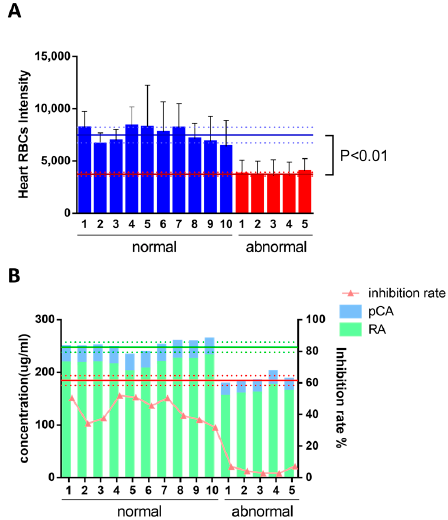
Figure 6. Heart red blood cell intensity in the zebrafish of normal and abnormal DHI ( A ) The distinction of the total concentration of RA and pCA in accordance with the inhibition rate between the normal and abnormal DHI; ( B ) The error bars represent the standard deviation based on ten repeated samples. Data in Figure 6A was represented by the mean ± SD and data in Figure 6B was represented by the mean, n = 10.